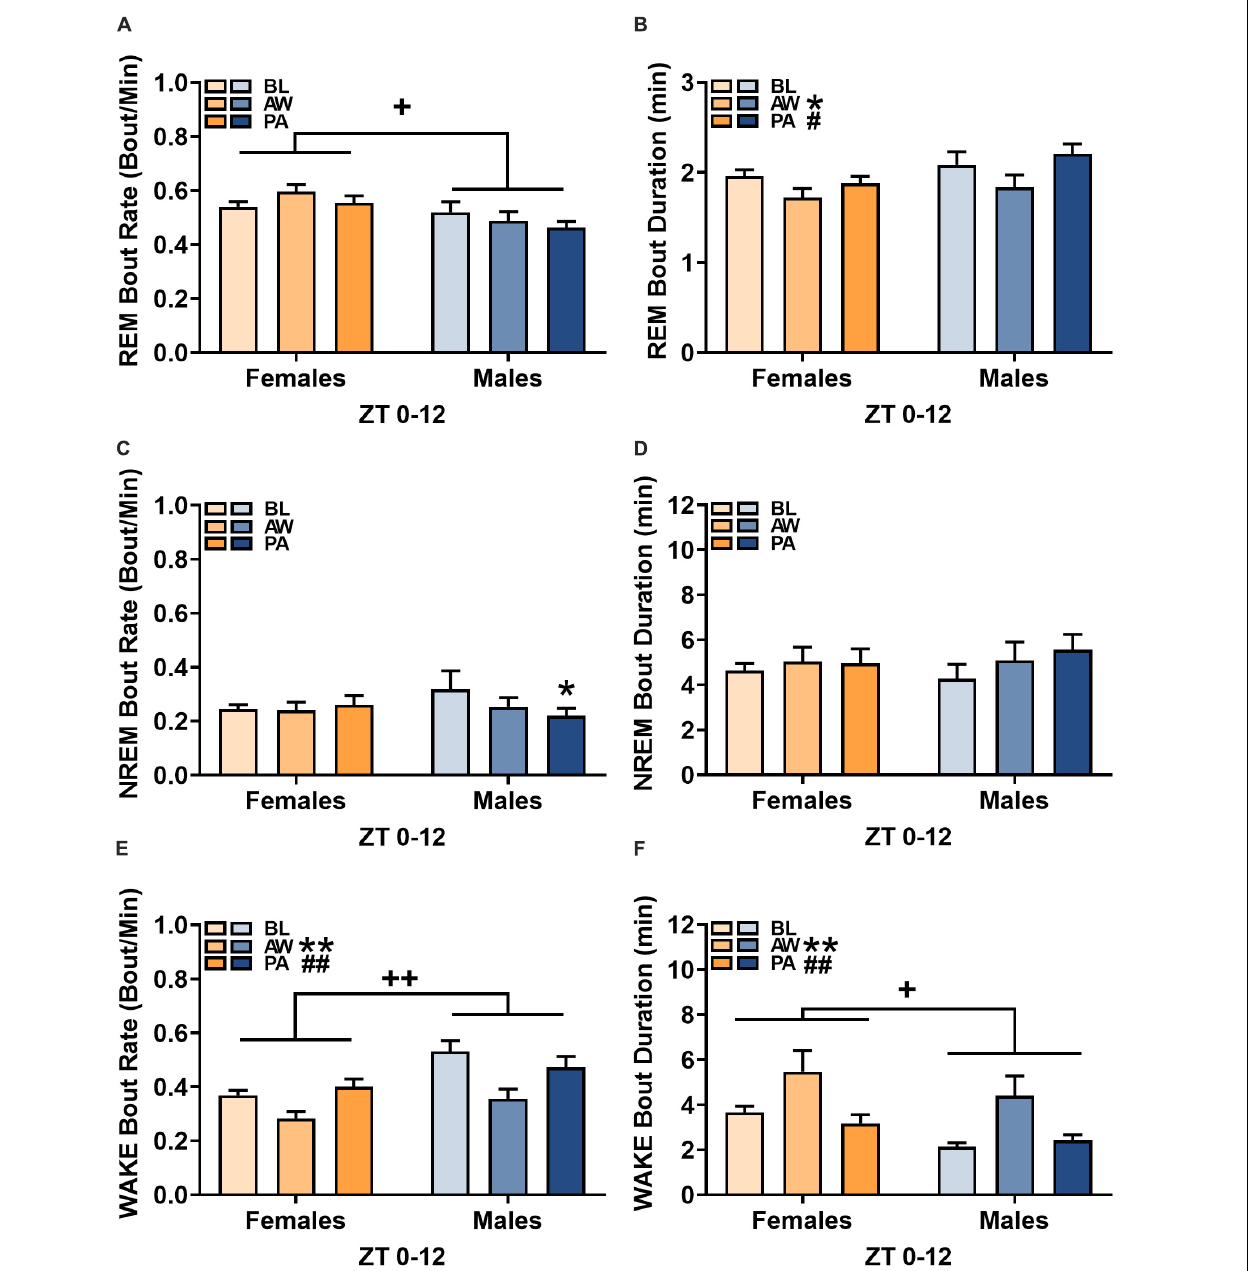
FIGURE 3 | Effects of alcohol withdrawal state [baseline (BL), acute withdrawal (AW), and protracted abstinence (PA)] on (A,C,E) mean bout rate (bouts/minutes; + SEM) and (B,D,F) mean bout duration (minutes; + SEM) for each sleep/wakefulness state (REM, NREM, and WAKE) in females (orange bars) and males (blue bars) over the whole 12-h period (ZT 0–12). * p < 0.05, ** p < 0.01 vs. BL; # p < 0.05, ## p < 0.01 vs. AW; + p < 0.05, ++ p < 0.01 females vs.